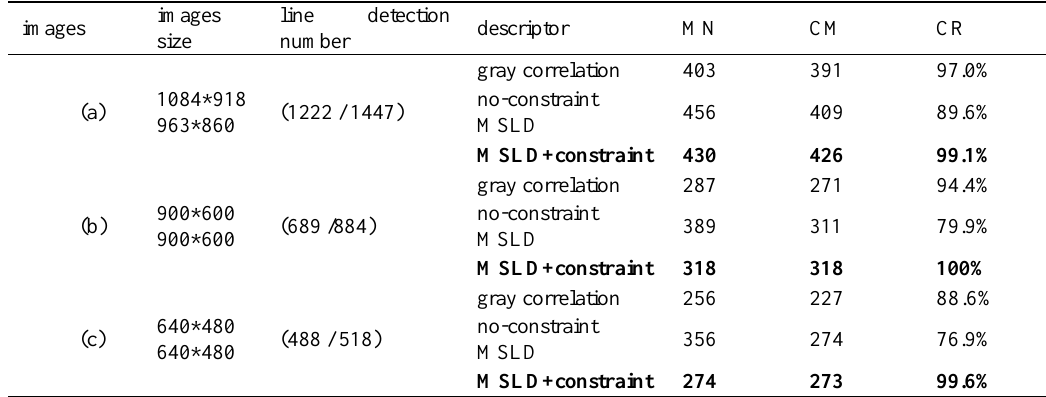
Fig.4 (a) Building area aerial close-range images and line matching results.(b) Different light close-range images and line matching results.(c) Rotating angle about  30 close-range images and line matching results. Tab.1 Line matching result by different